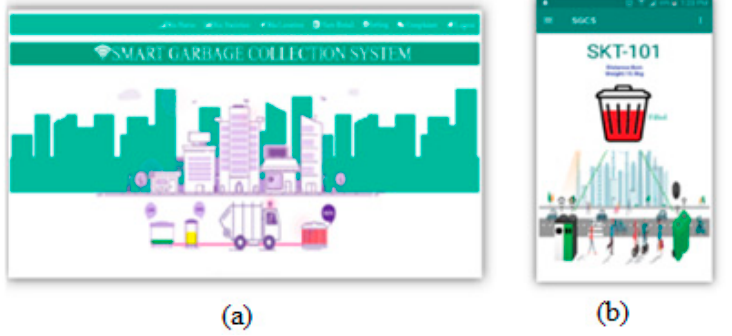
Figure 5. ( a ) Web interface; ( b ) Android notifications.